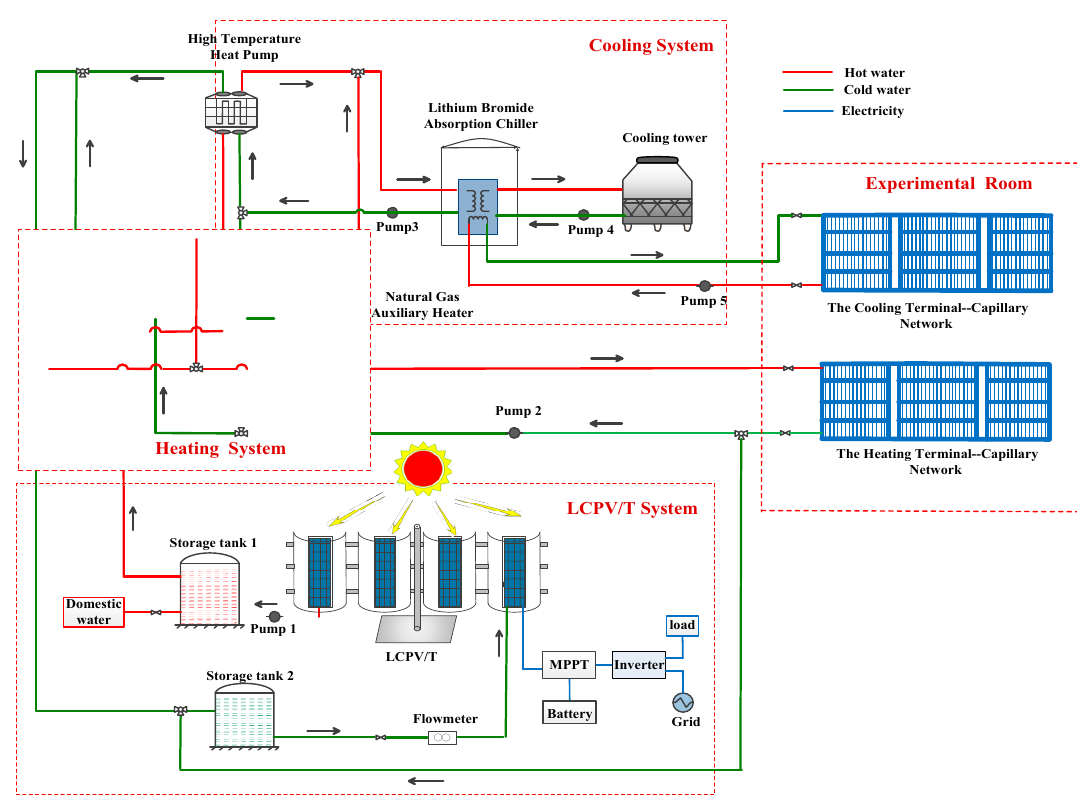
Figure 1. The configuration of the natural gas-assisted solar low-concentrating photovoltaic/thermal trigeneration (NG-LCPV/T-TG) system.